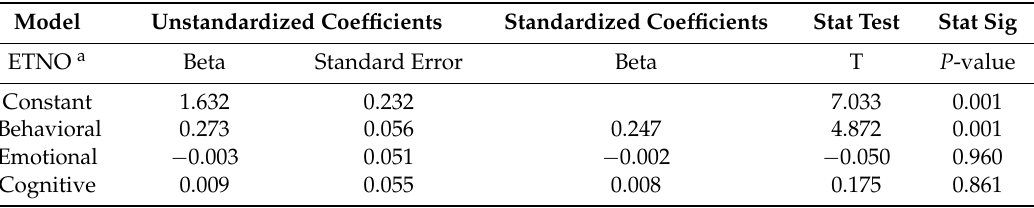
Table 3. Multiple Linear Regression on the Consumer Ethnocentrism: Coefficients a